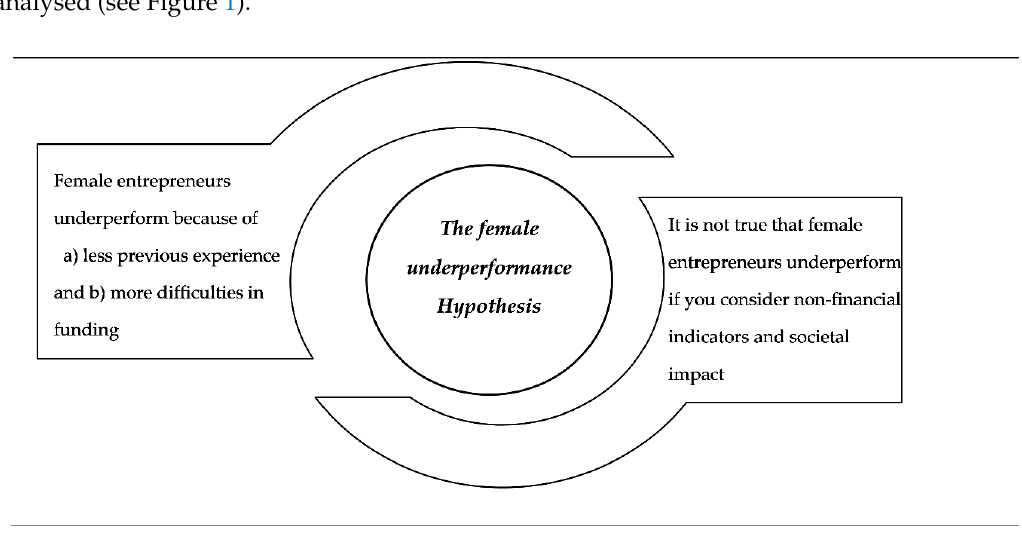
Figure 1. The academic debate on the “female underperformance hypothesis” .